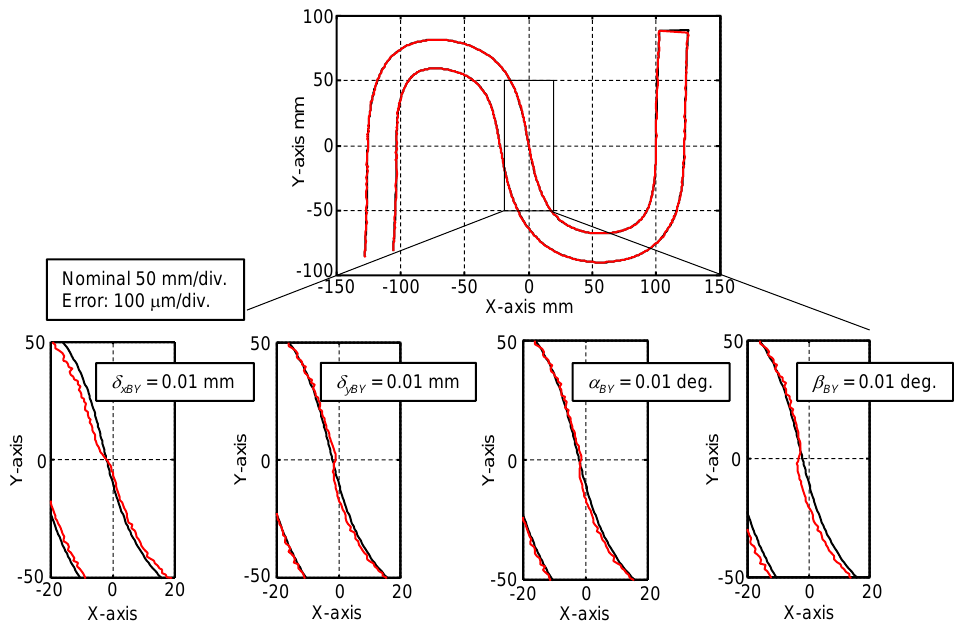
Figure 10. Influence of geometric errors on motion trajectory of tool center-point.